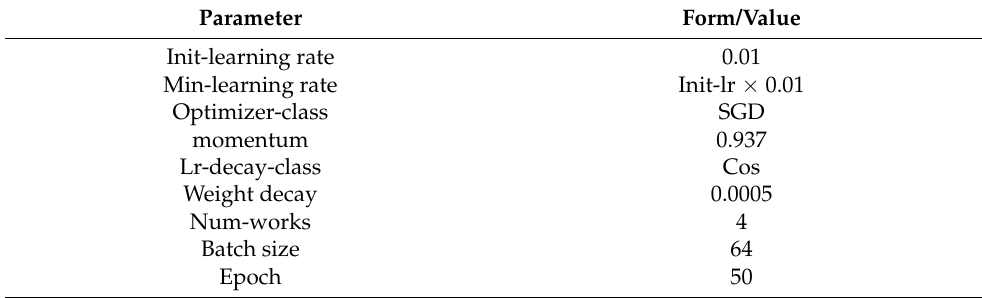
Table 5. Initial training